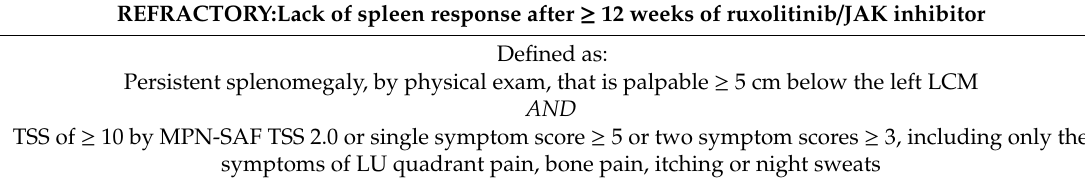
Table 2. Definition of MF relapsed / refractory to JAK inhibitor therapy in the KRT-232 trial [70]. RELAPSED: Progressive disease any time while on ruxolitinib / JAK inhibitor Defined as: Increase in spleen volume by ≥ 25% from nadir by MRI / CT Appearance of new splenomegaly palpable ≥ 5 cm below LCM ≥